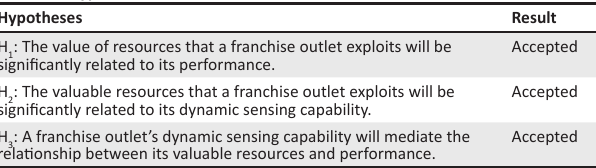
TABLE 2: Hypotheses. Hypotheses